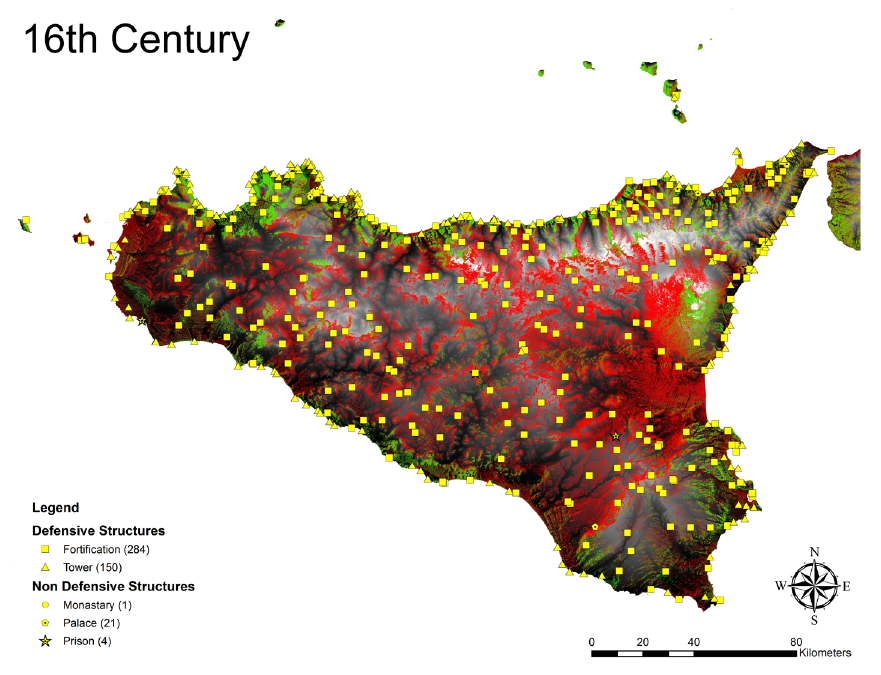
Figure 7. Figure showing the distribution of defensive structures and their viewsheds in the 16th century. Fortifications are represented by squares and the area they have surveillance over is in red whereas towers are represented by triangles and the area they have surveillance over is in green. As one can see through this picture, there is a growing trend in the use of coastal towers along the coast and a growing focus on the exterior of the island. Also included are church buildings represented by circles, palaces represented by hexagons, and prisons represented by a star. Image derived from an ASTER GDEM (a product of NASA and